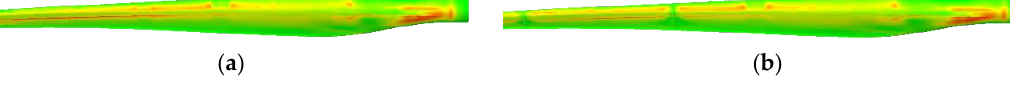
Figure 7. Contour plots of the transverse true strain values. ( a ) Using a “flexible” distributing coupling; ( b ) using a “rigid” multi-point constraint.